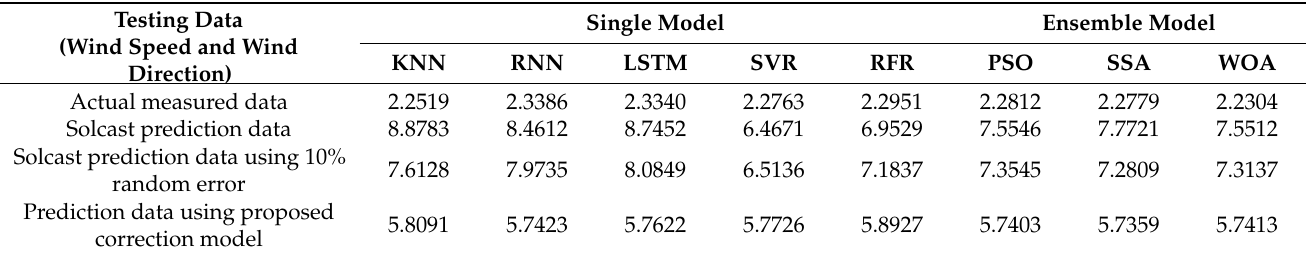
Table 11. Forecasting results for average MRE using actual data, Solcast prediction data and corrected data.